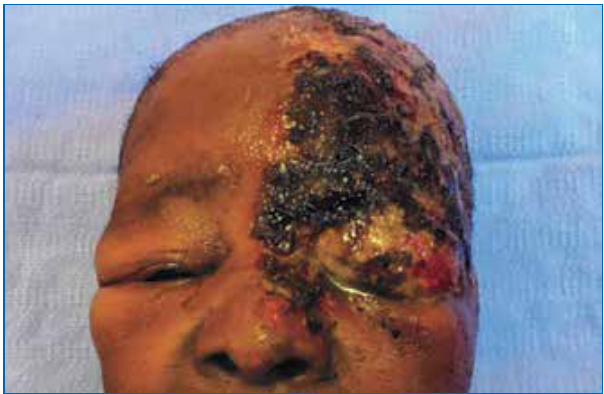
Figure 1: Herpes zoster affecting the neck.